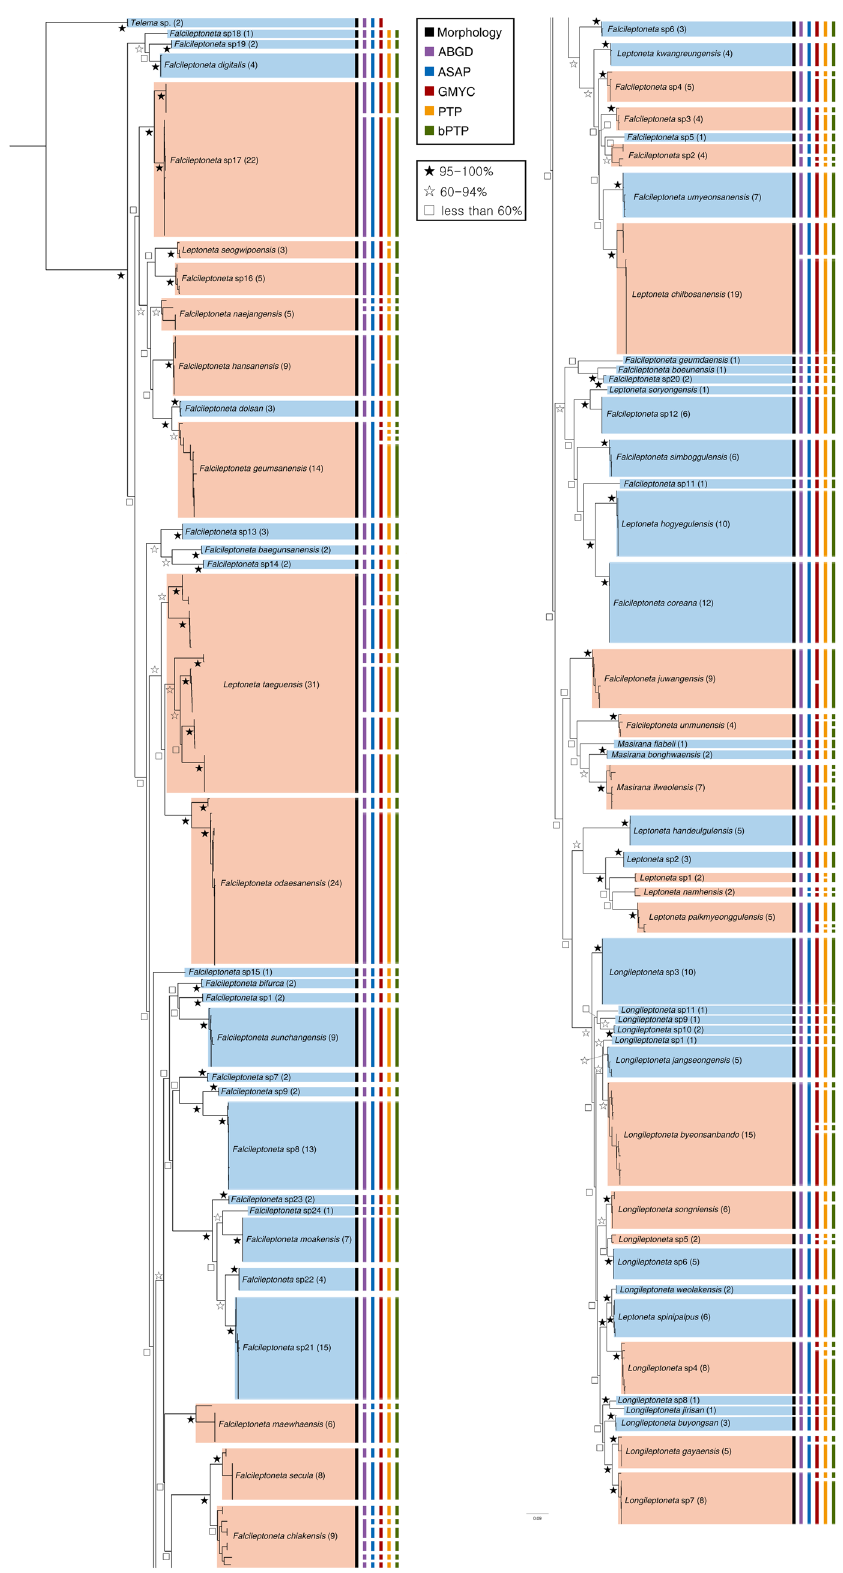
Figure 2. Maximum Likelihood (ML) tree of 424 COI sequences, including morphological analysis and results of five different species delimitation methods. Color bars indicate the results of each delimitation method. In the ML tree, blue panels indicate that all species delimitation methods match with morphological identification, while red panels show one or more methods